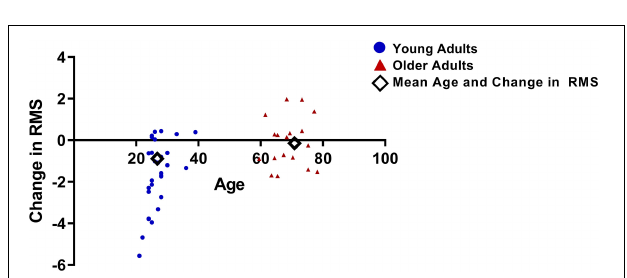
FIGURE 6 | Difference in RMS values between pre and post tetanization for young and older adults, calculated as the change in pre to post RMS for the late